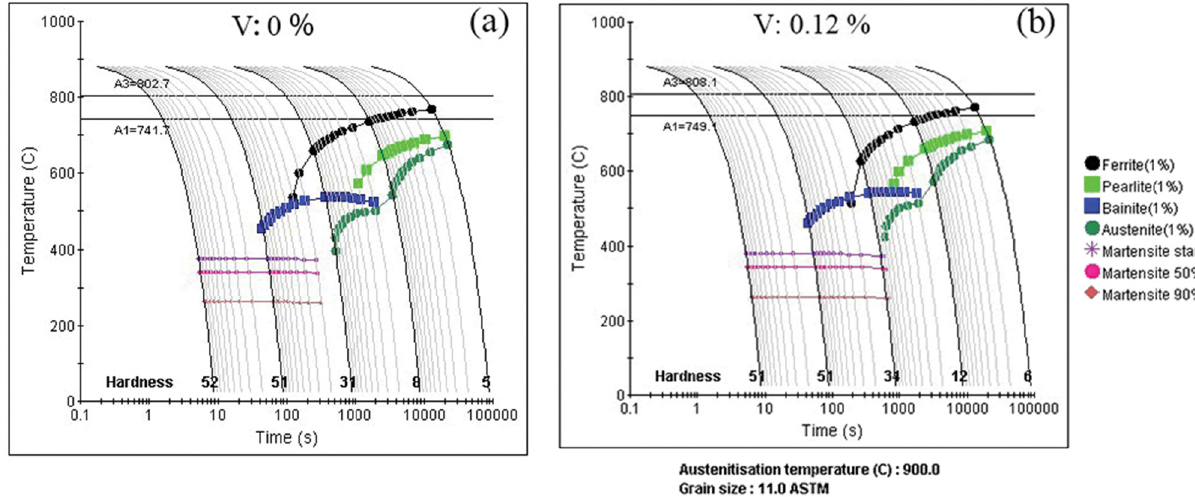
Figure 17: CCT curves calculated by J Mat Pro software: ( a ) steel 5#; ( b ) steel 6#.